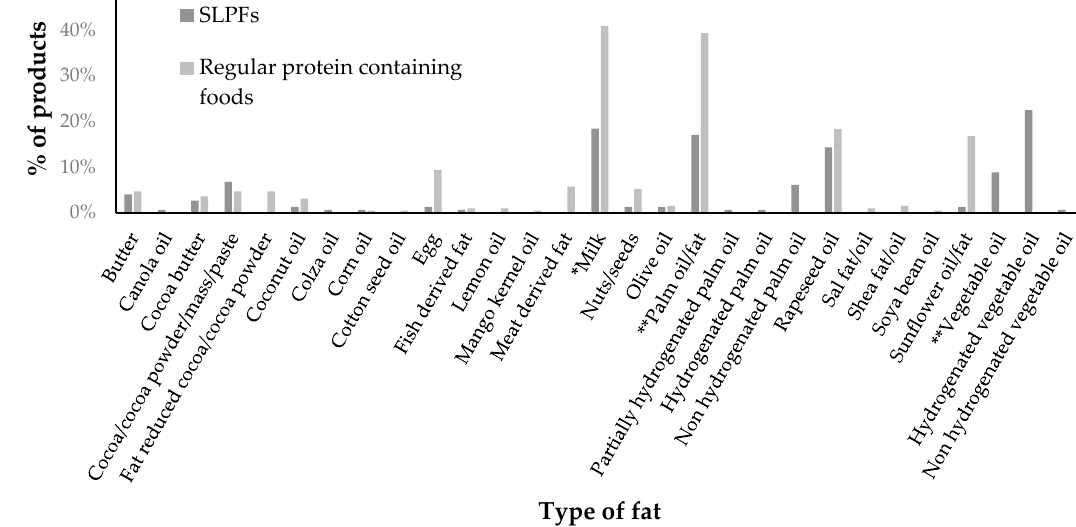
Figure 2. Percentage of SLPFs and regular protein containing foods containing di ff erent types of fat in their ingredient lists. * Not including milk protein (where products specified this as an ingredient) ** oil/fat, did not specify whether it was hydrogenated or non-hydrogenated .